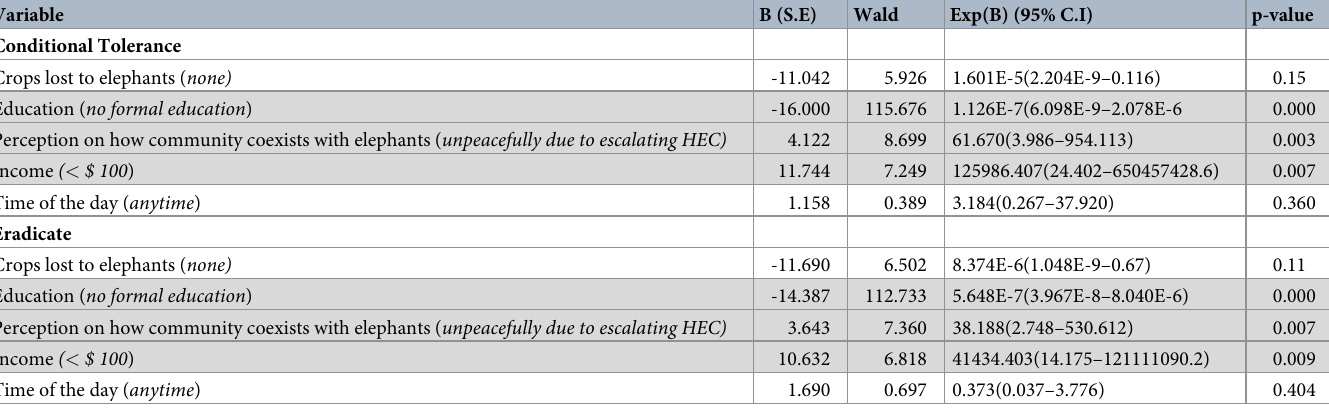
Table 3. Multinomial logistic regression results for local communities tolerance towards